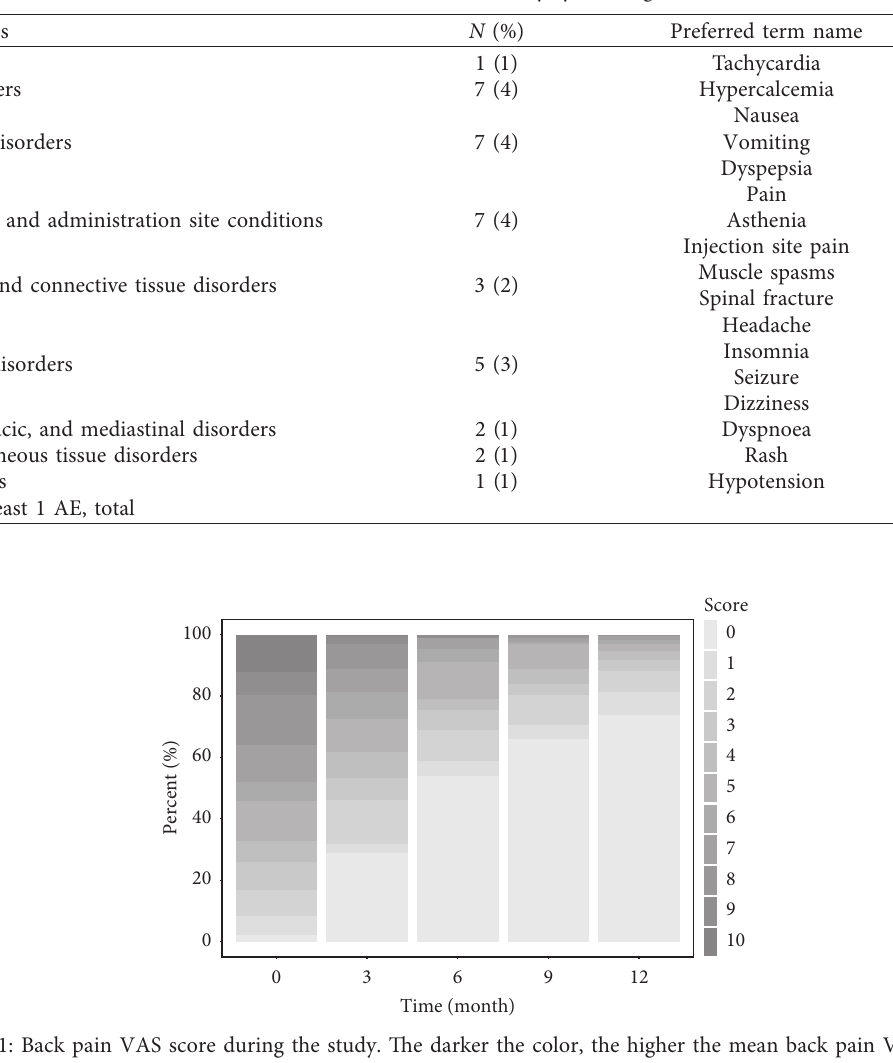
Table 2: Incidence of adverse events by system organ class.